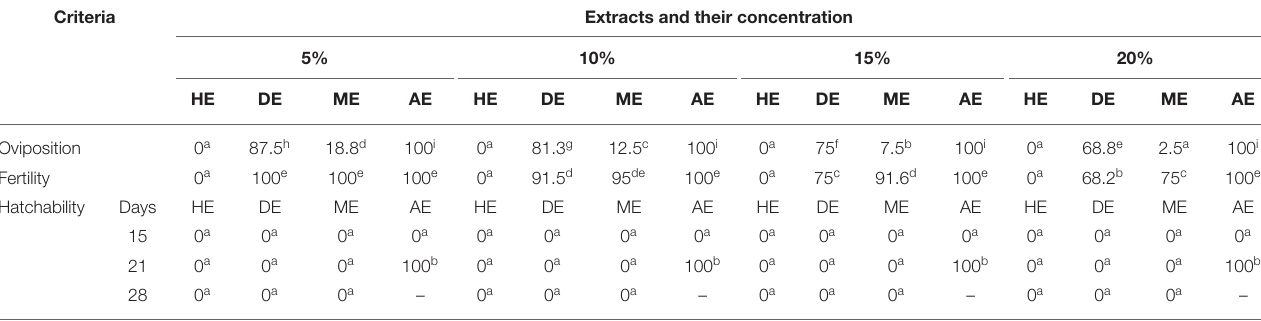
TABLE 5 | Effect of 5, 10, 15, and 20% neem seed extracts on reproductive performance of Hyalomma dromedarii including oviposition, fertility, and hatchability. Criteria Extracts and their